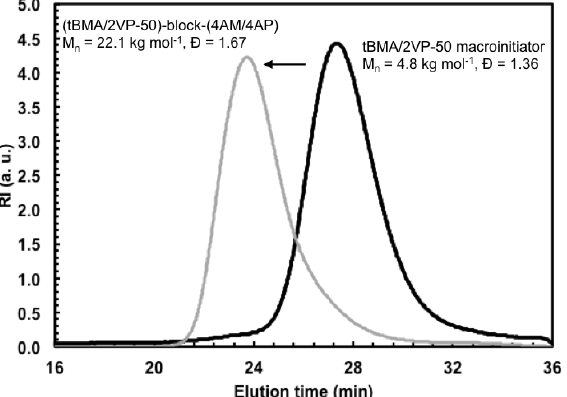
Figure 4. GPC chromatograms of the poly( t BMA- stat -2VP) macroinitiator ( t BMA/2VP-50) (black line) and the chain-extended product after fractionation of poly( t BMA- stat -2VP)- b -poly(4AM- stat -4AP) (grey line).